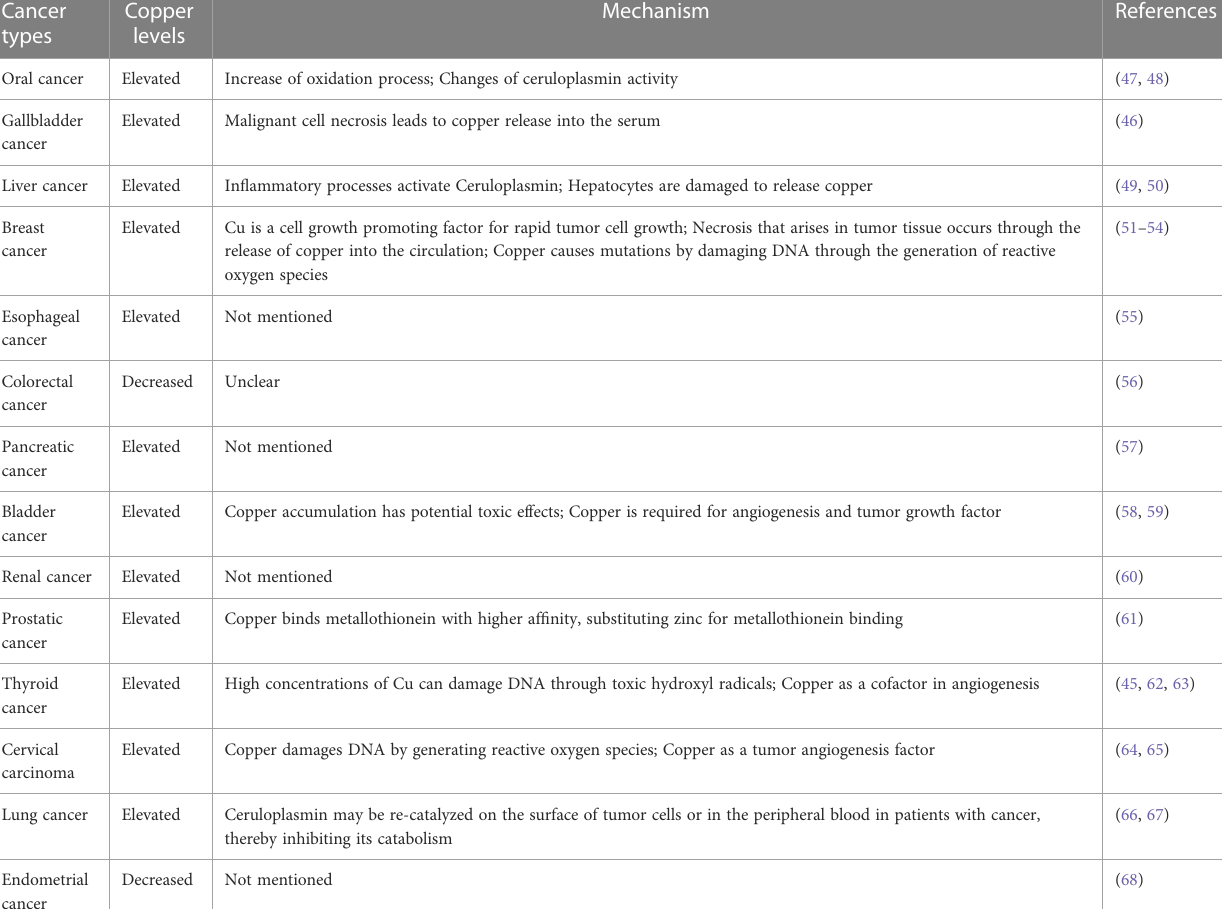
TABLE 2 Copper level variation in the serum of different cancers.